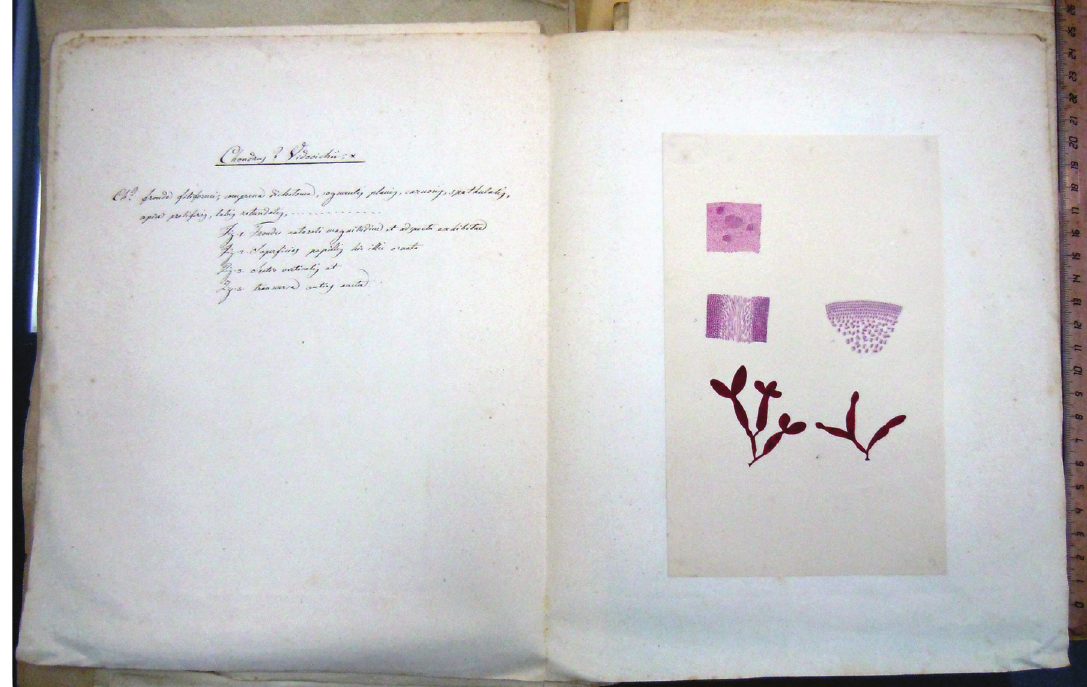
Fig. 6. Plate and caption of Chondrus? vidovichii (Menegh.) Zanardini from Meneghini’s manuscript “ Alghe Dalmate, Enumerate ed Illustrate dal Professor Giuseppe Meneghini